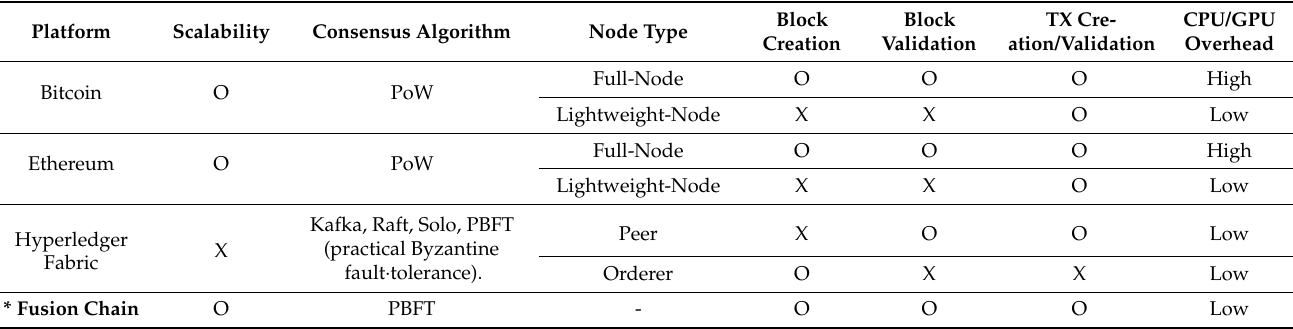
Table 3. Comparison of roles by blockchain